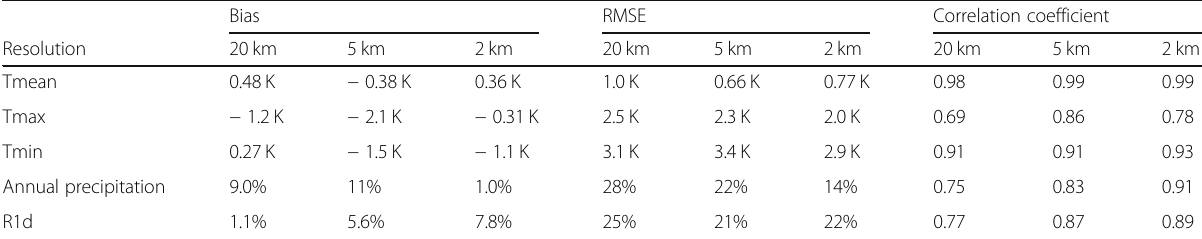
Table 2 Biases, RMSDs, and correlation coefficients Bias RMSE Correlation